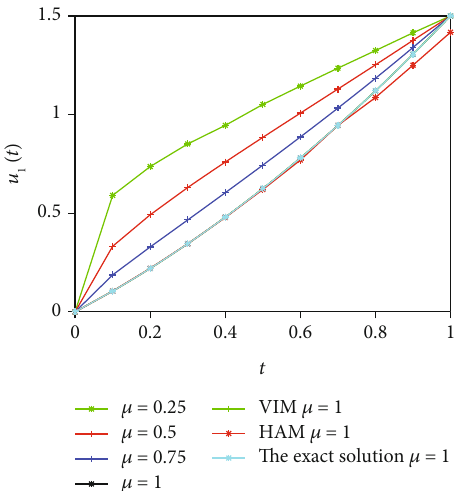
Figure 27: The numerical solution of u Example 3 in Ref. [4].